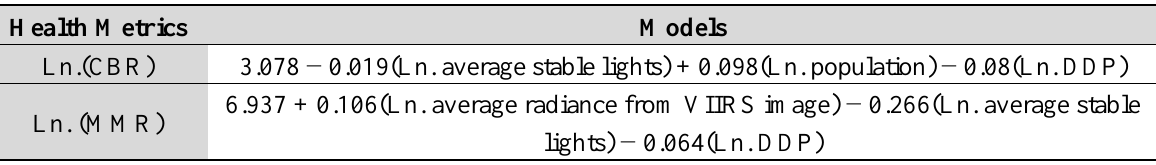
Table 7. Models to predict CBR and MMR.